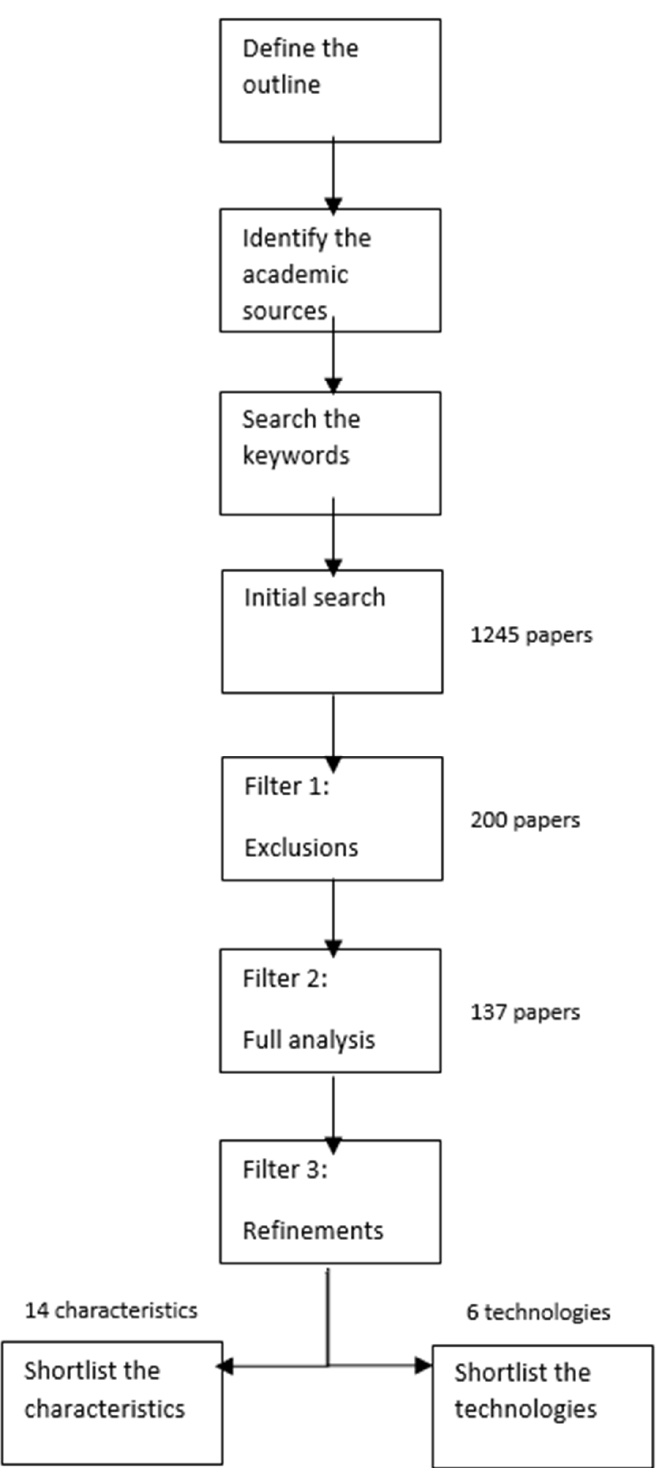
Figure 3. Review